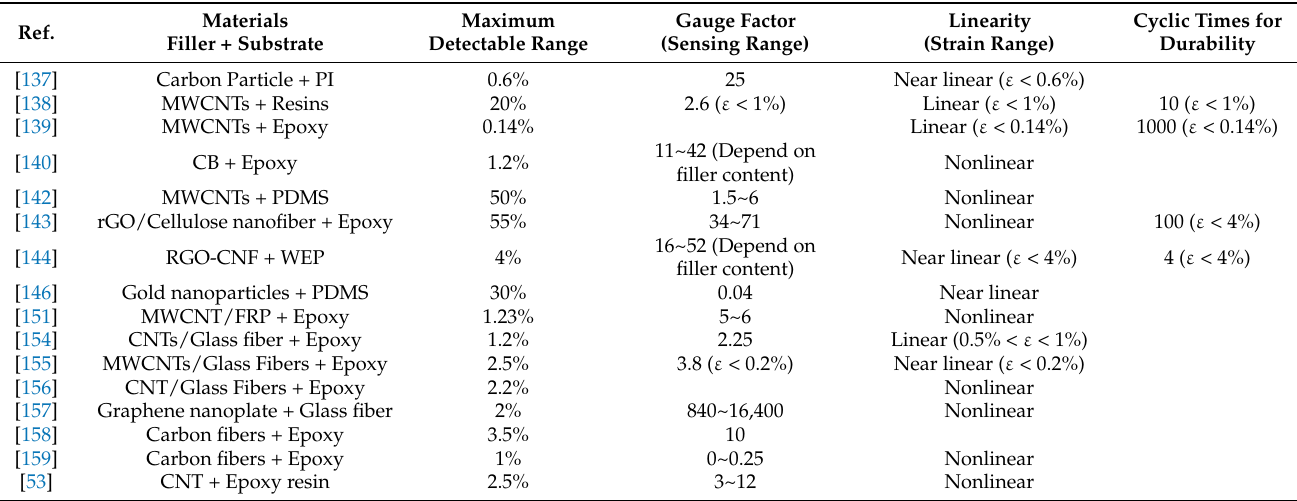
Figure 12. ( a ) Electrode disposition on the CNT/epoxy coating; ( b ) damages on the slab; ( c ) two- dimensional electrical resistance mapping of crack detection; ( d ) normalized resistance variation under tensile strain; ( e ) gauge factor variation under tensile strain; ( f ) normalized resistance variation with damage length [53] (Copyright 2017, Elsevier B.V.). Table 4. Piezoresistive strain sensors for civil SHM.